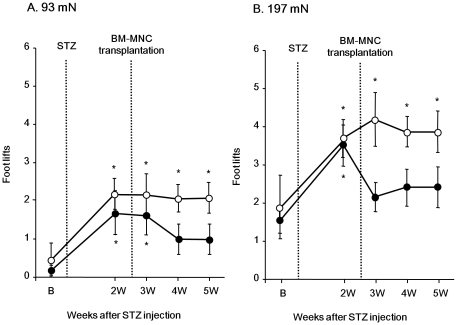
Inhibitory effects of BM-MNC transplantation on mechanical hyperalgesia induced by STZ administration.Number of foot withdrawals in response to the 93 (A) and 197 mN (B) von Frey hair (VFH) stimulation in diabetic rats is shown. Data are presented as mean ± SEM. Vertical axis, number of foot lifts; horizontal axis, order of the test (weeks after STZ injection). Broken line shows the time point of STZ administration and BM-MNC transplantation. In the treatment group (solid circles), BM-MNC injection was carried out just after the measurements at 2 weeks (2W) after the STZ injection (n = 8). In the control group (open circles), saline injection was done (n = 6). Repeated measures two-way ANOVA identified a significant difference in the day-effect between BM-MNC transplanted and control group. *P<0.05 compared with before (B) STZ injection (one-way ANOVA with Dunnett's tests).